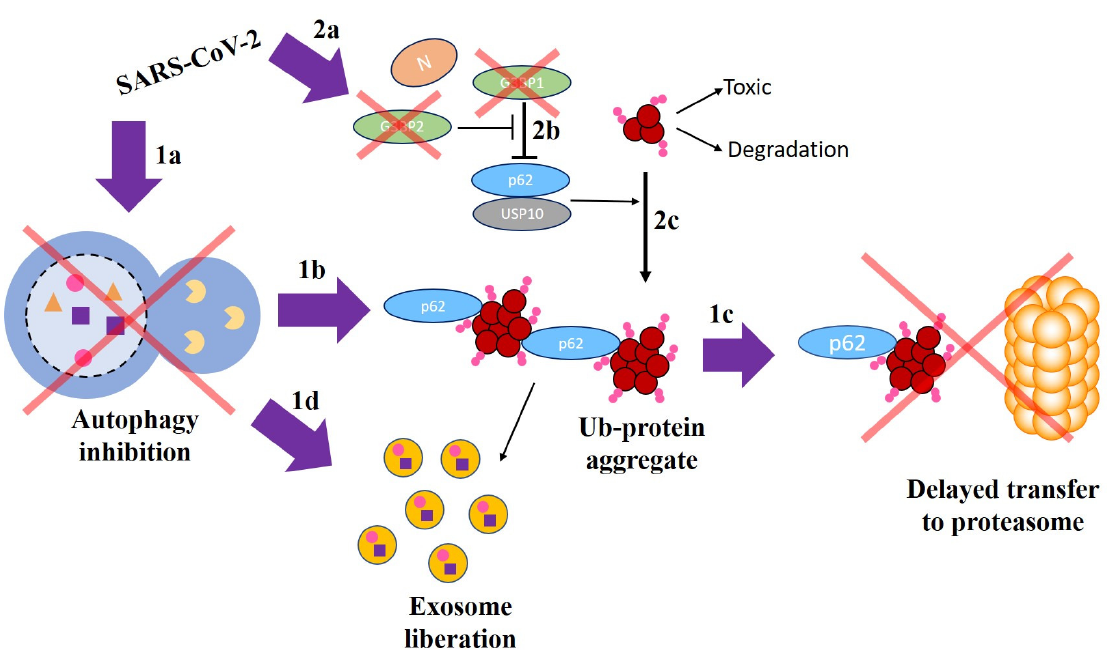
Figure 4. A schematic model explaining the involvement of NUP62 and G3BP1 proteins in the development of PD due to the effects of SARS-CoV-2 (see text for